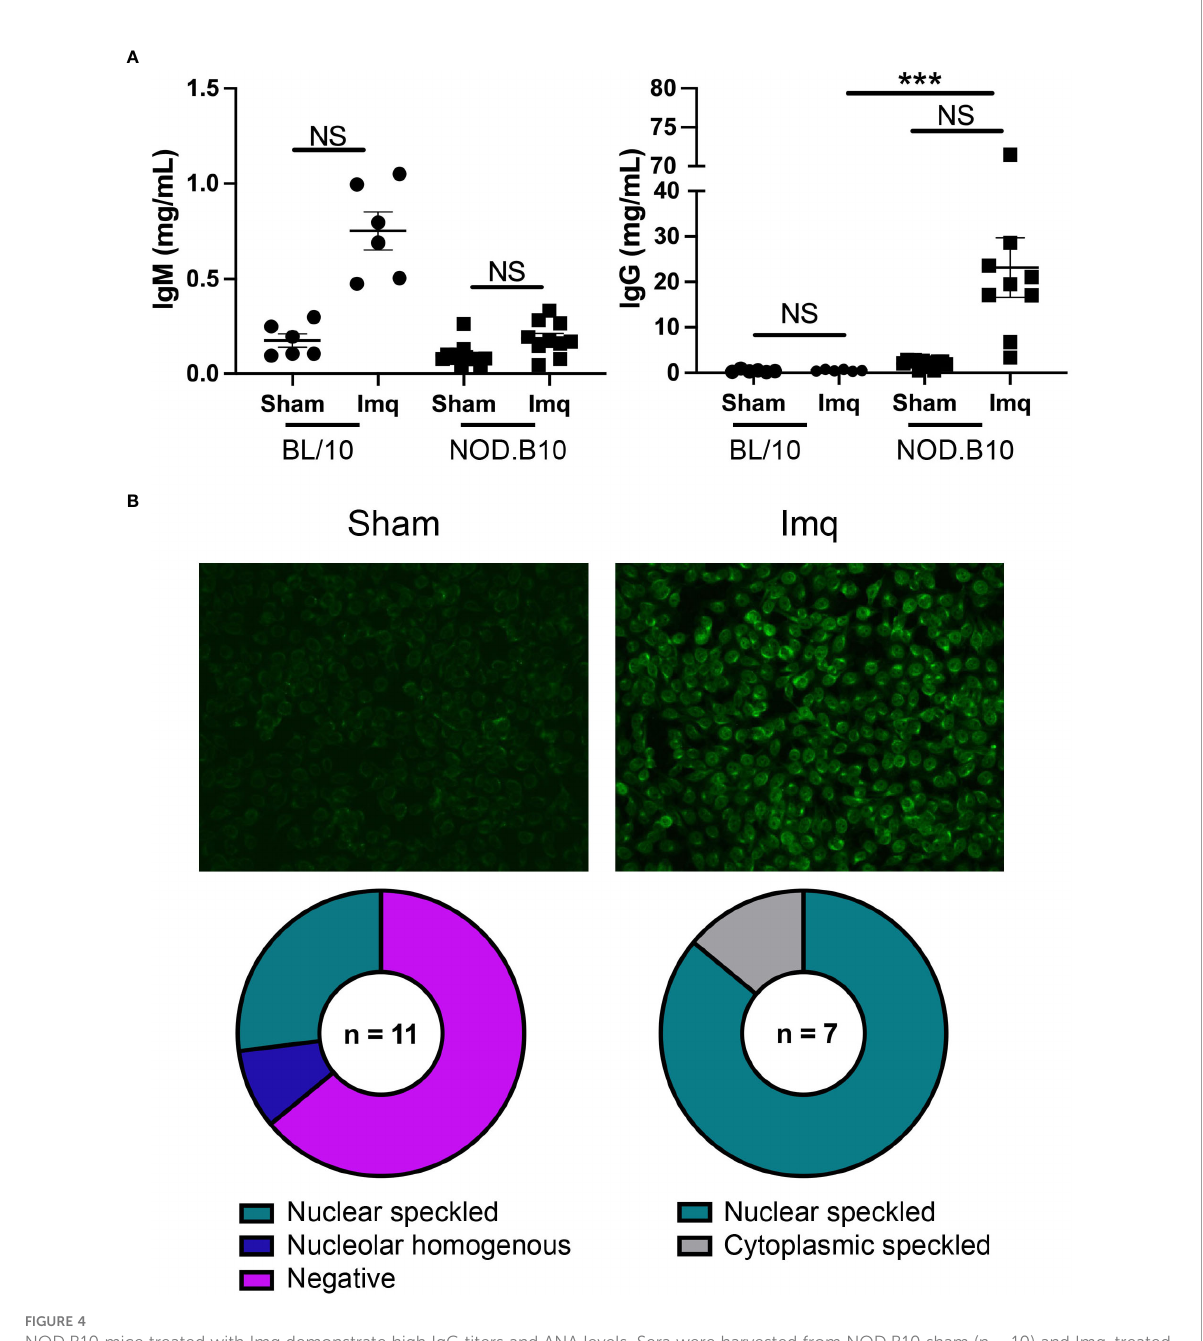
FIGURE 4 NOD.B10 mice treated with Imq demonstrate high IgG titers and ANA levels. Sera were harvested from NOD.B10 sham (n = 10) and Imq-treated female mice (n = 9) and from BL/10 sham (n = 6) and Imq-treated female BL/10 mice (n = 6) by cardiac puncture following euthanasia. (A) Total IgM and IgG titers were quanti fi ed by ELISA. Horizontal lines represent the mean and SEM (NS, non-signi fi cant, ****p < 0.0001). (B) Anti-nuclear autoantibodies were detected by HEp2 staining. One representative image is shown from each